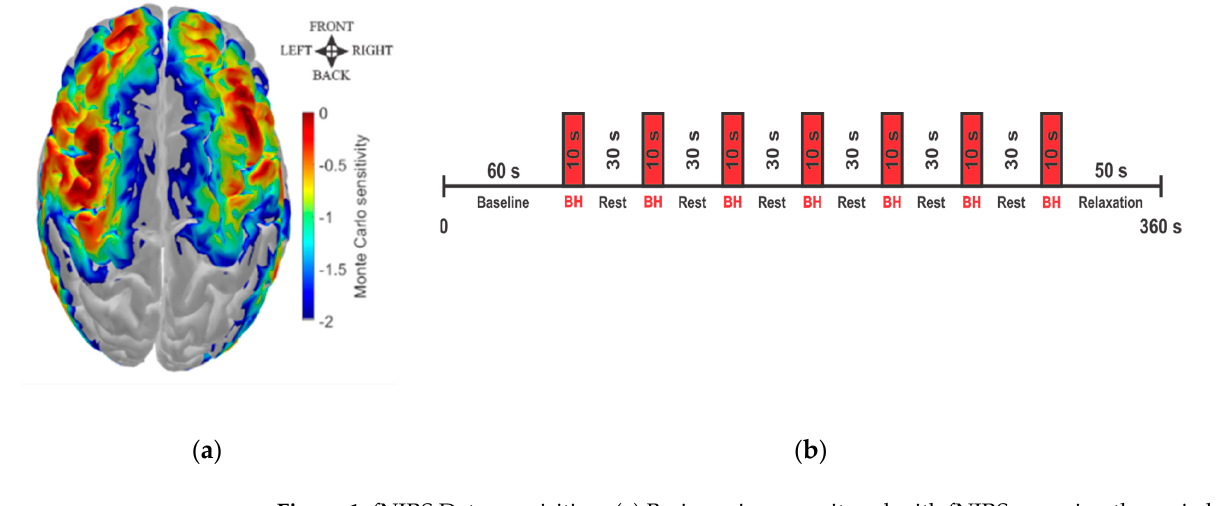
Figure 1. fNIRS Data acquisition. ( a ) Brain regions monitored with fNIRS, covering the main brain areas irrigated by the carotid artery. The color bar represents a map of photon sensitivity based on Monte Carlo simulations performed with AtlasViewer [31]; the red color represents regions with high photon sensitivity, while blue represents low − photon sensitivity. ( b ) Experimental protocol performed by all participants, consisting of up to seven breath-holding trials of 10 seconds each, followed by 30 seconds of rest for a total of 6 minutes of acquisition.